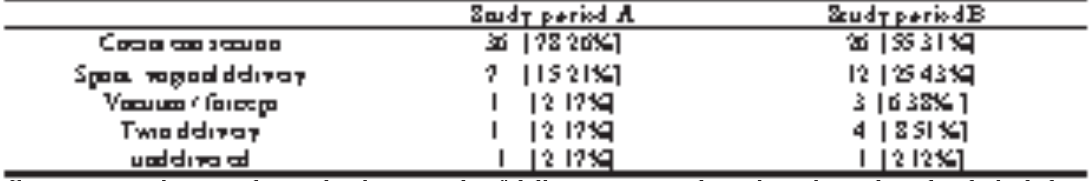
Most patients presented at term pregnancy during both study period. Table VI : Mode of delivery